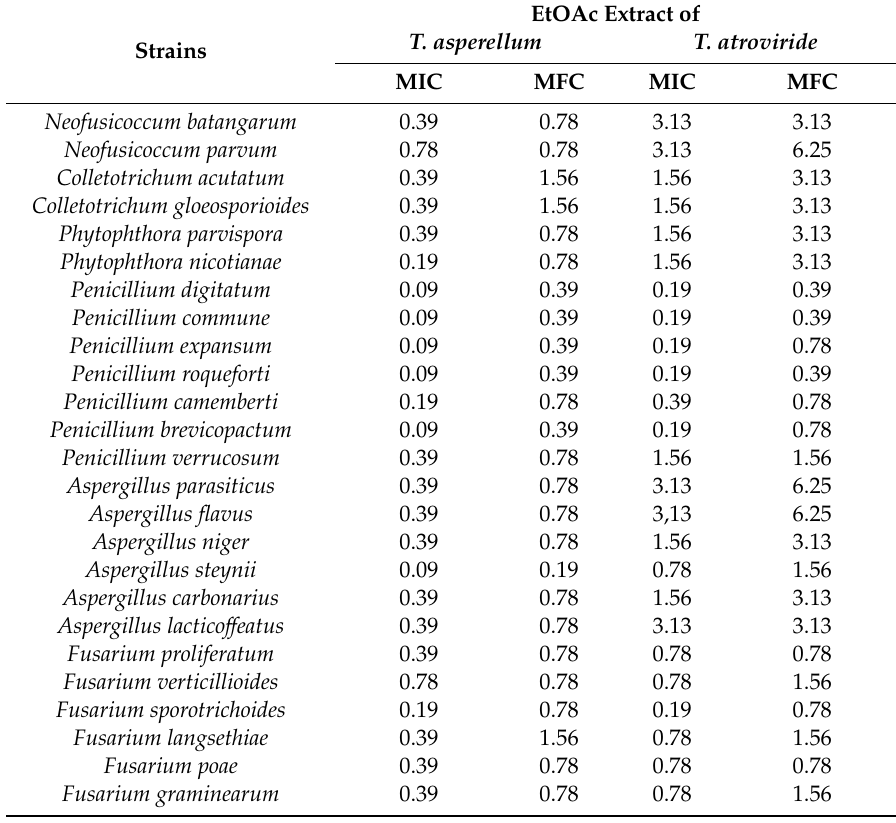
Table 2. Minimum inhibitory concentration (MIC) and minimum fungicidal concentration (MFC). Values of the EtOAc extracts of Trichoderma asperellum IMI393899 and T. atroviride TS on tested fungus and oomycete